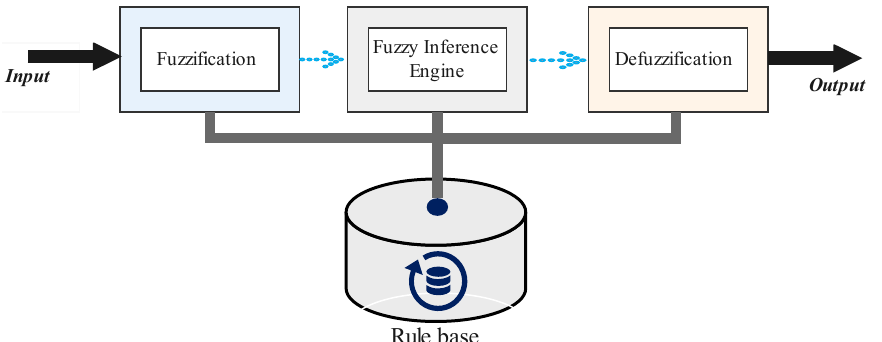
Figure 8. Fuzzy logic controller structure.